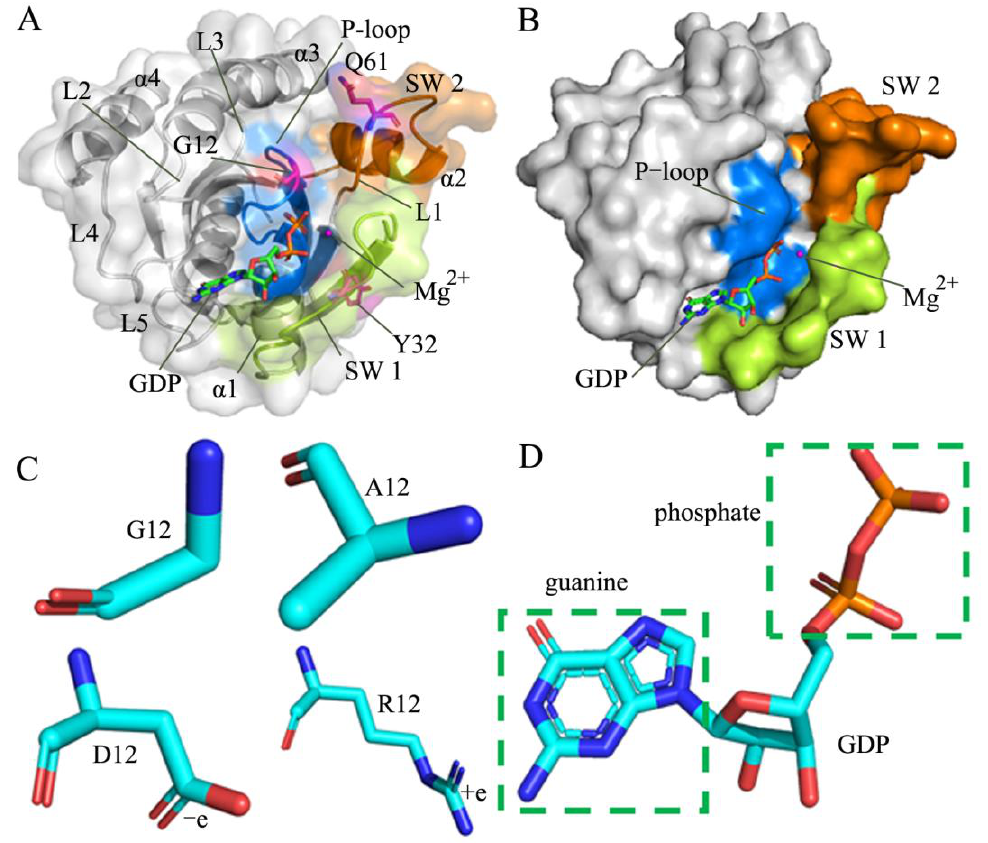
Figure 1. Structural information: ( A ) the GDP/WT KRAS complex, in which KRAS is shown in surface and cartoon modes while GDP, magnesium ion, and key residues are displayed in stick, ball, and stick modes, respectively, ( B ) binding sites of GDP to KRAS displayed in surface styles, ( C ) changes of structure and polarity or hydrophobicity due to mutations of G12 into A12, D12, and R12, in which key residues shown in stick modes and ( D ) GDP displayed in stick patterns. In Figure 1A and 1B, the blue, limon and orange respectively indicate the P-loop, SW 1 and SW